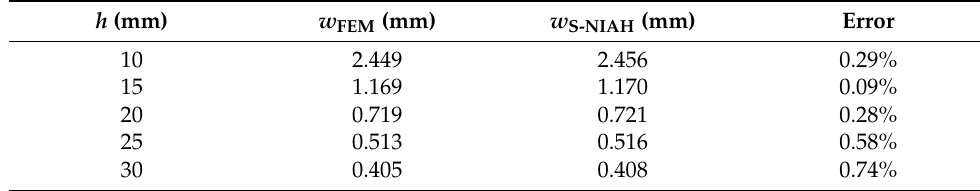
Table 2. Deflections and errors at centre of plate versus h